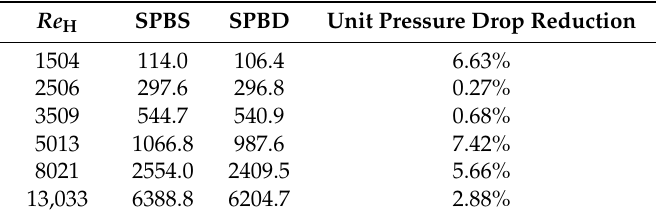
Table 2. The unit pressure drop of the structured packed beds with smooth or dimpled spheres at N = 1.00 (Pa · m − 1